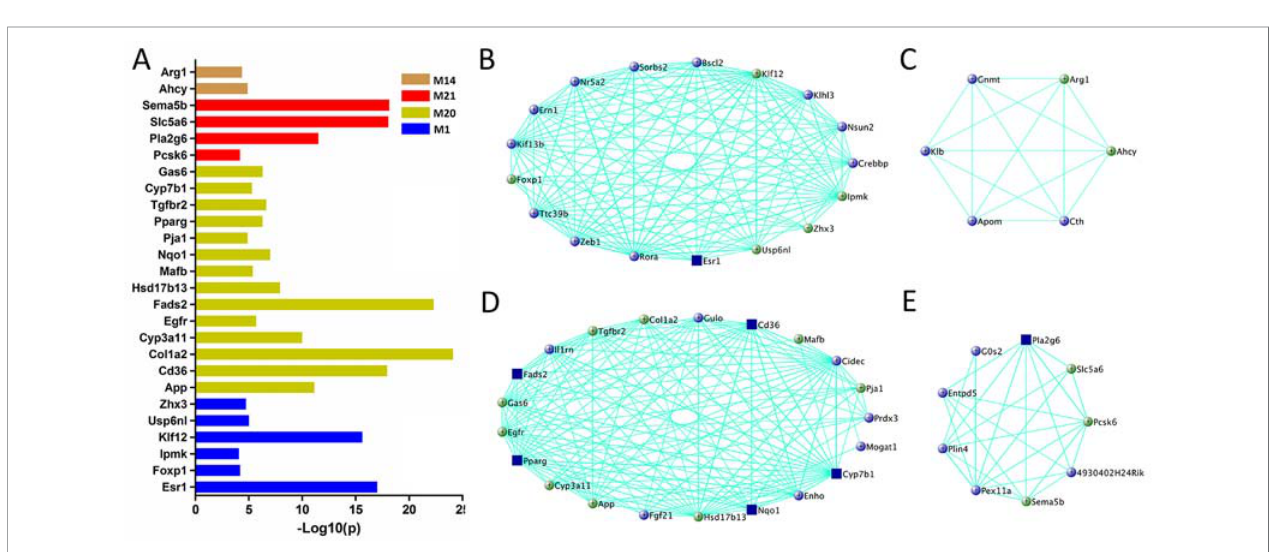
FIGURE 5 | Gene prioritization for TG-associated modules. (A) Human GWAS overlapping genes for TG-associated modules. Genes with GWAS p value <1 × 10 − 4 of TG level were retrieved from GRASP and GWAS Catalog. (B – E) Gene subnetworks for module M1, M14, M20, and M21. The coloring scheme is same as Figure 4C